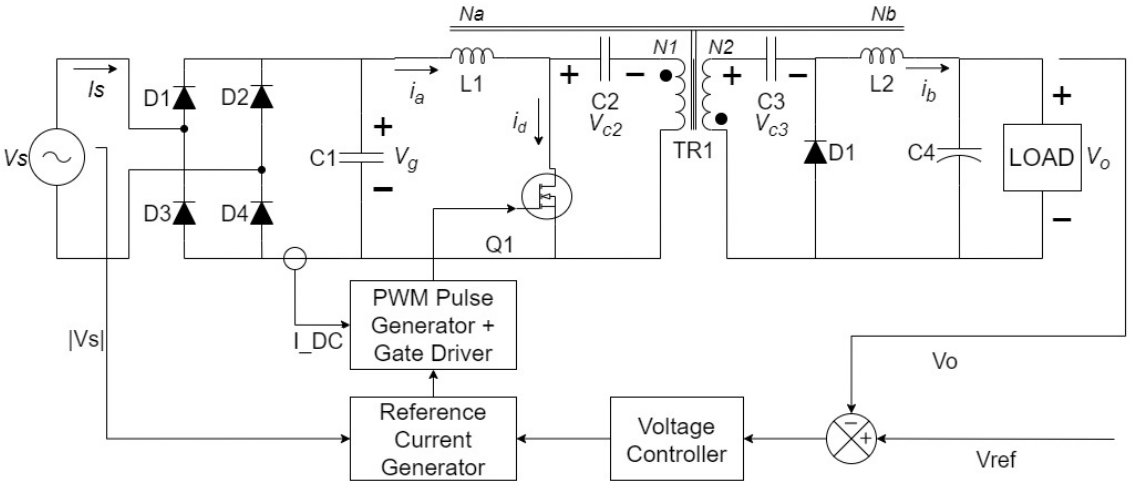
Figure 3. Isolated PFC Cuk converter with integrated magnetics supplied by single-phase AC.